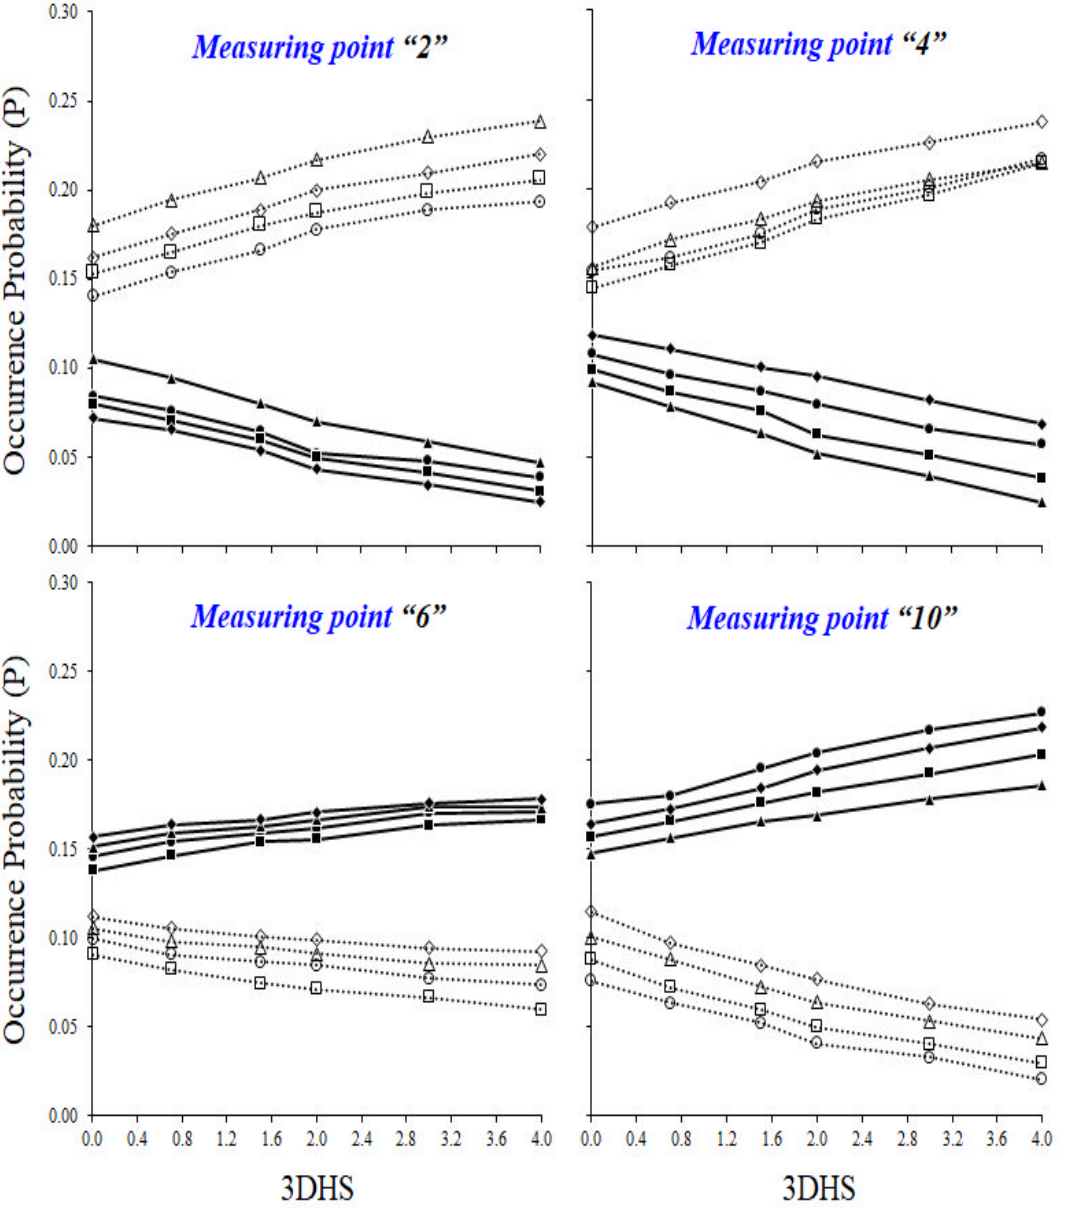
Figure 13. Depth-averaged occurrence probabilities of the octagonal bursting events with 3DHS values for the experimental run 4R: P 1 (filled circles), P 2 (unfilled circles), P 3 (filled squares), P 4 (unfilled squares), P 5 (filled triangles), P 6 (unfilled triangles), P 7 (filled diamonds), and P 8 (unfilled diamonds). Continuous lines indicate odd octagonal events, while dashed lines denote even events.